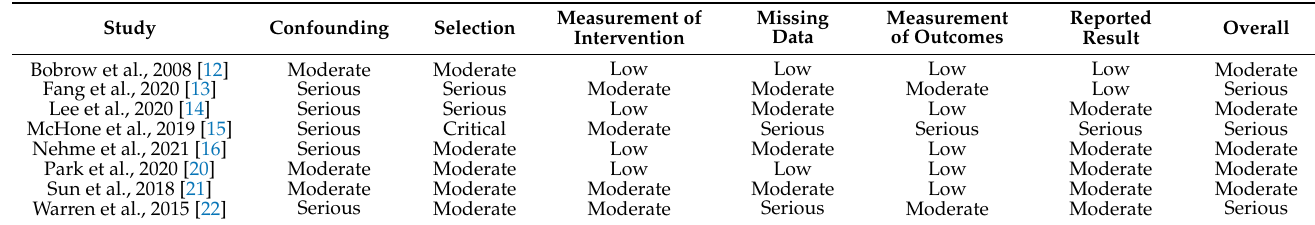
Table 2. Risk of bias assessment with the ROBINS-I